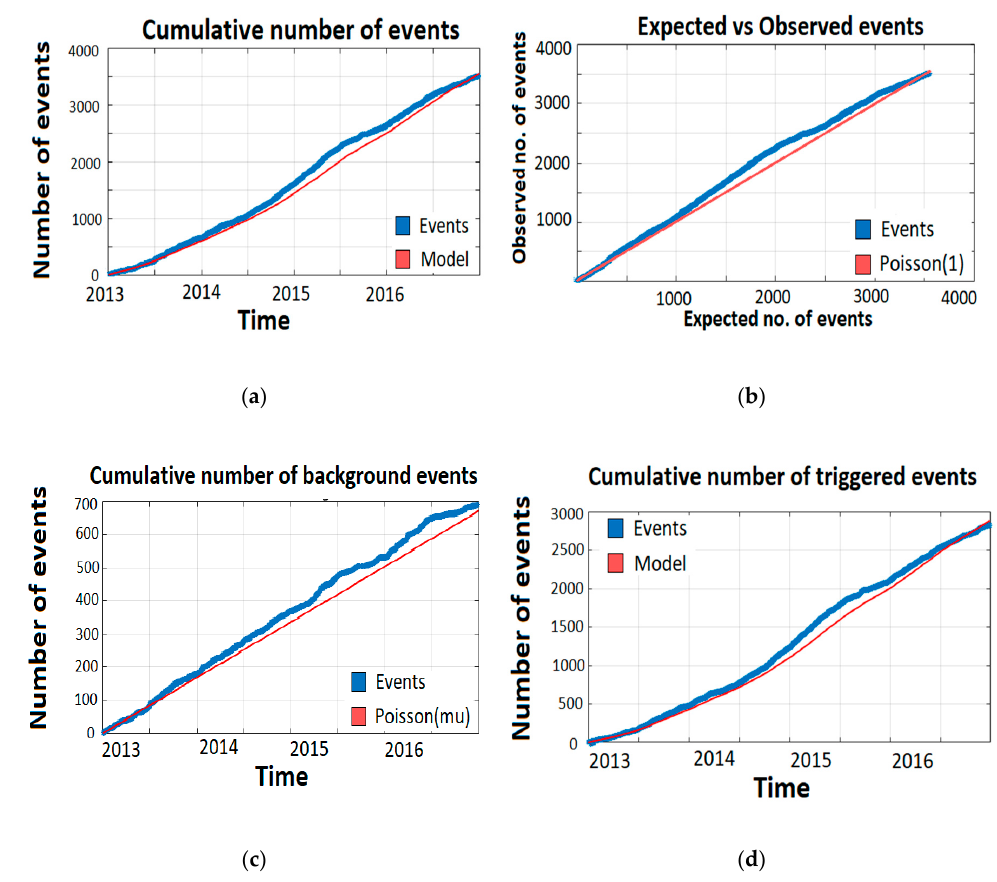
Figure 10. Results of the residual analysis for the North Africa catalog. In the top left ( a ) figure the observed number of events is plotted against the transformed times from (11). In the top right figure ( b ), the observed number of events (blue) is plotted against the expected number of events by the model (red). In the bottom two figures ( c ) and ( d ), the observed number of background and triggered events (blue) are compared with the number of events expected by the model (red). The parameter k governs the expected number of direct aftershocks caused by an